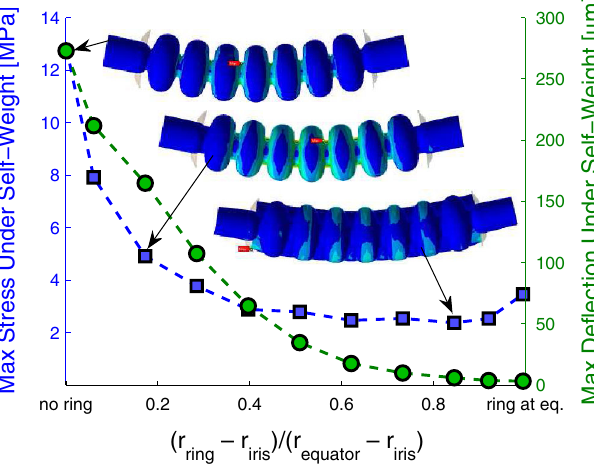
FIG. 15. Effect of gravity on a cavity seated on its enddishes.